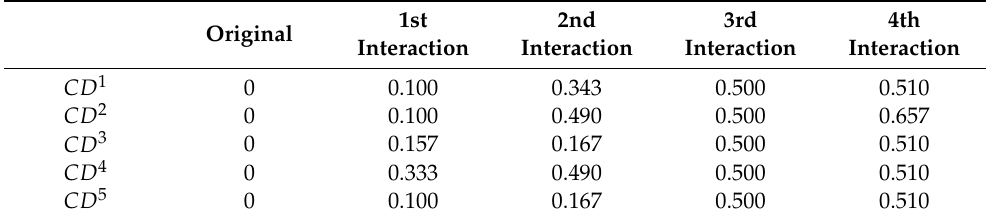
Table 3. Consensus degrees of experts in each round of